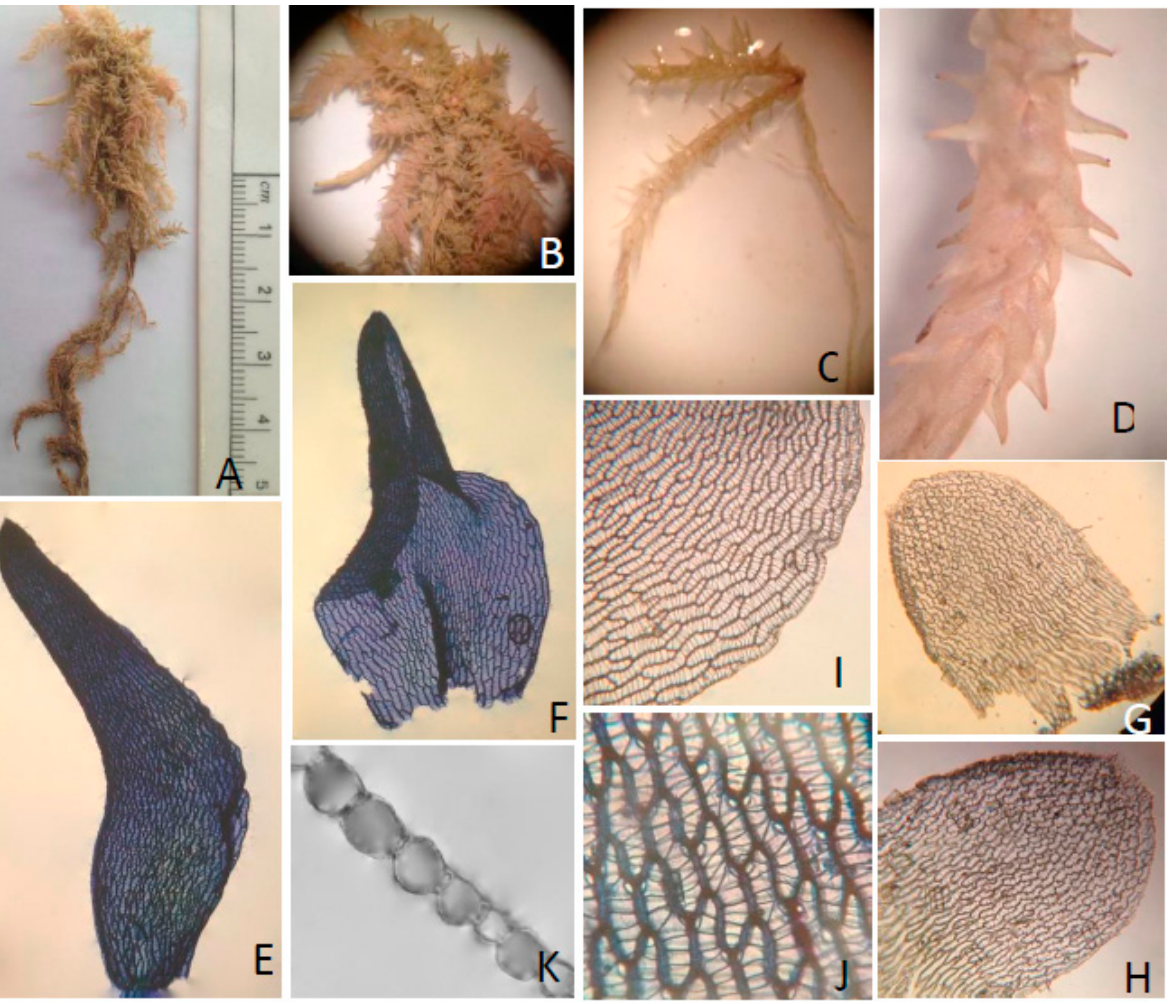
Figure 2. Sphagnum squarrosum Crome. A. Habit. B. Detail of terminal bud. C. Fascicle. D. Detail of the branch leaves. E, F. Branch leaves. G, H. Stem leaves. I. Marginal cells of branch leaf. J. Median cells of branch leaf, inner surface. K. Branch leaf in cross section (A Sehnem 334). Photos by Denise